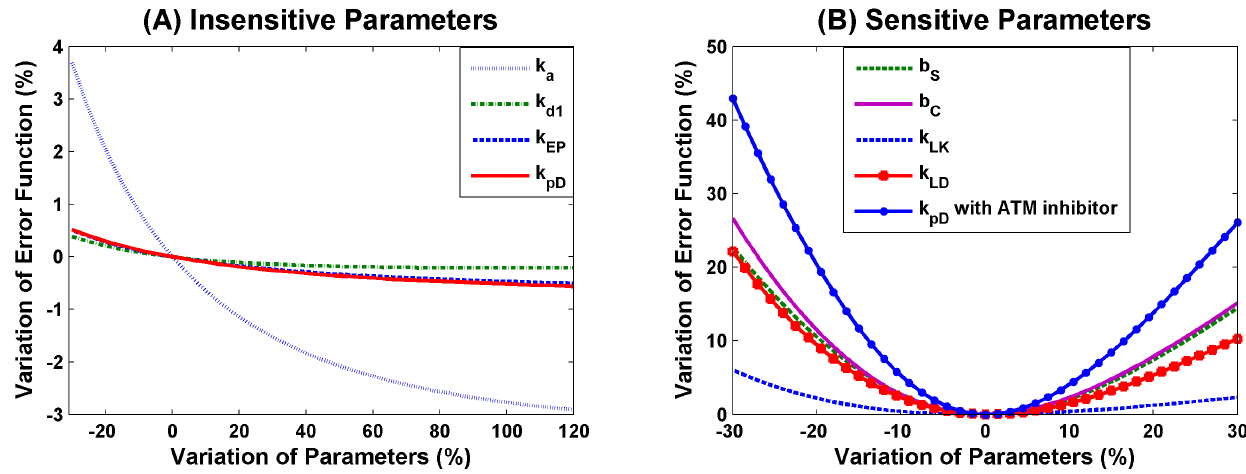
Figure 6. Sensitivity analysis of parameters in the SF Model 1. Let p* be the ‘‘optimal’’ parameter set given in scheme (10) obtained by gradient method. The x-axis presents the variation ( E ( p ) { E ( p (cid:2) ) ) x 100% of the data fitting error when p (cid:2) ( E ( p ) parameters whose variation by more than 30% leads to error variation by below 5%, suggesting that the model is robust to these parameters. Panel (B) includes five parameters whose variation by 30% leads to error variation by over 5%.